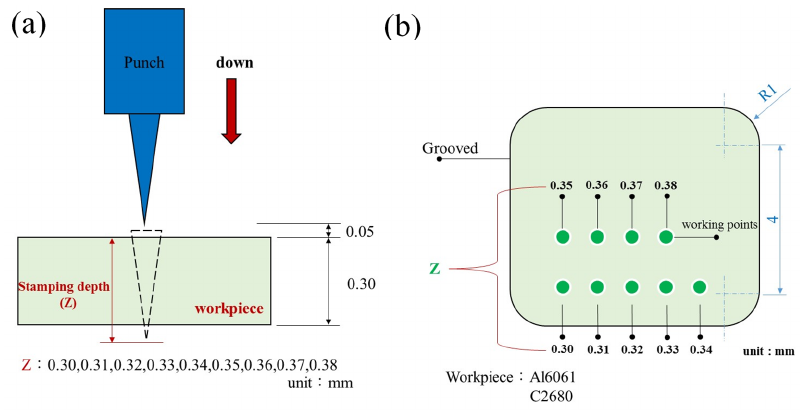
Figure 7. Schematic diagram of processing mode ( a ) stamping depth definition ( b ) working point